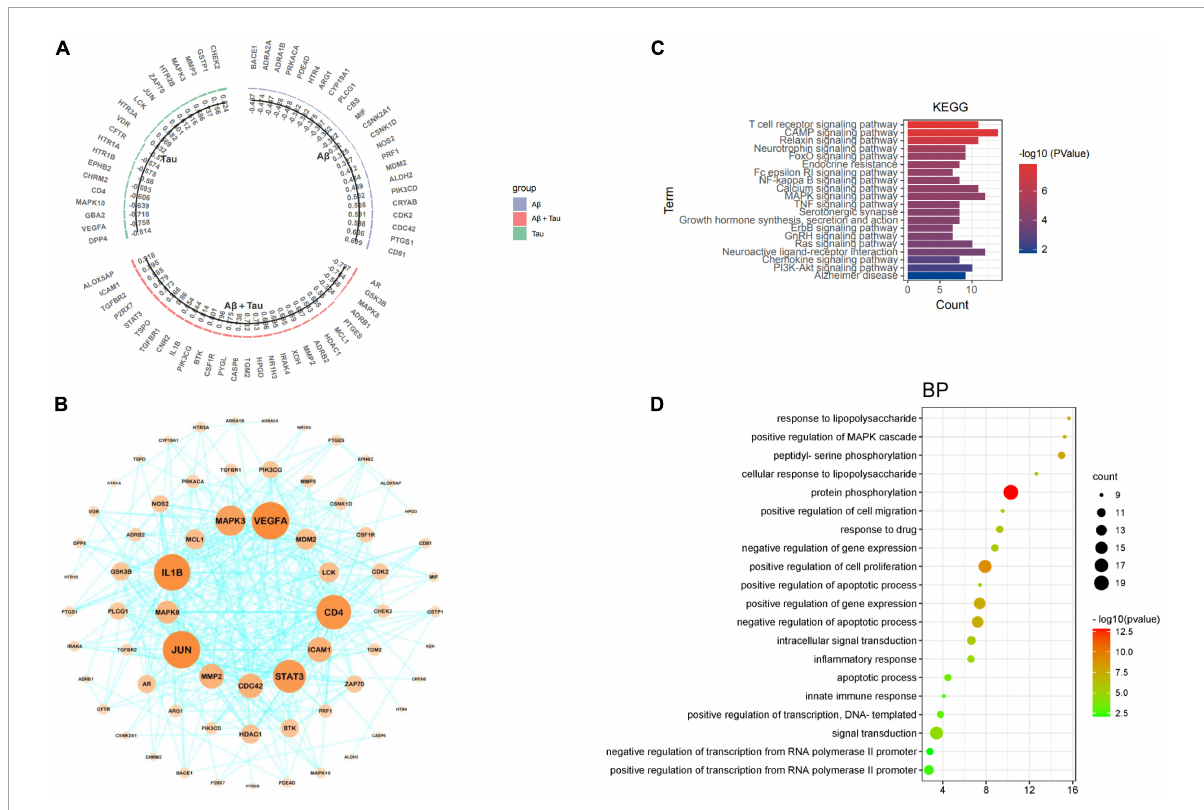
FIGURE11 (A) Bar graph showing target genes with tau and A β information. (B) Bioinformatics analysis of FRP targets associated with tau and A β pathology. (C) Tau and A β -related targets of the KEGG pathway. (D) Enrichment analysis identified bubble maps associated with the top 20 biological processes